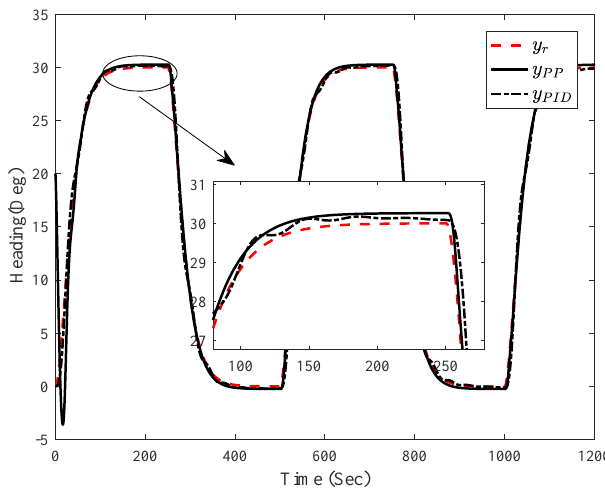
Figure 4. Curves of ship’s heading and its desired heading angle.